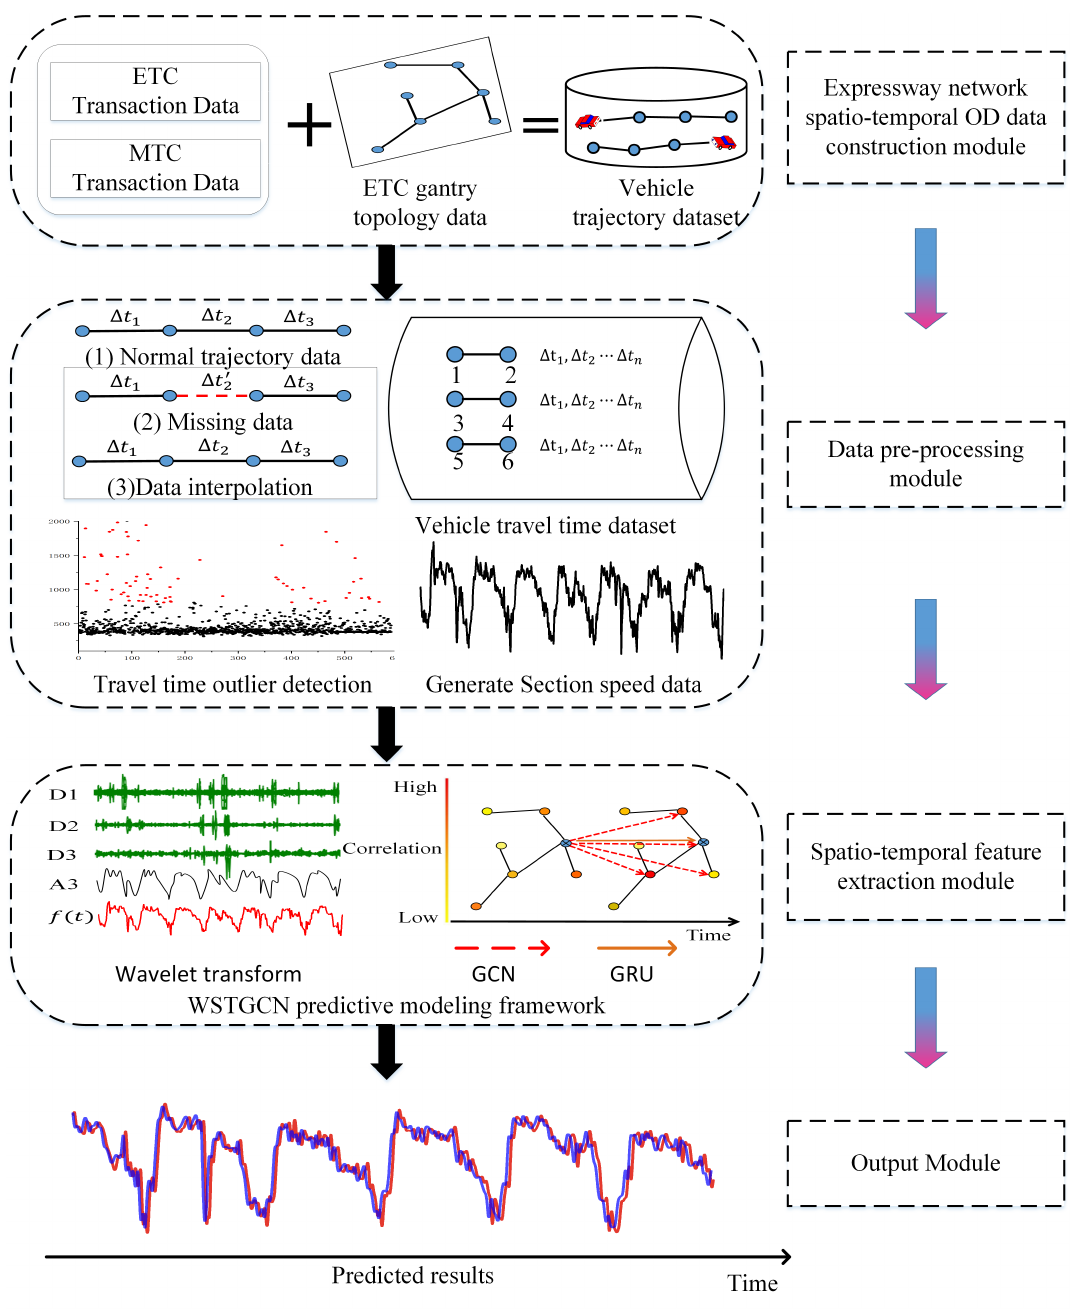
Figure 1. Overall